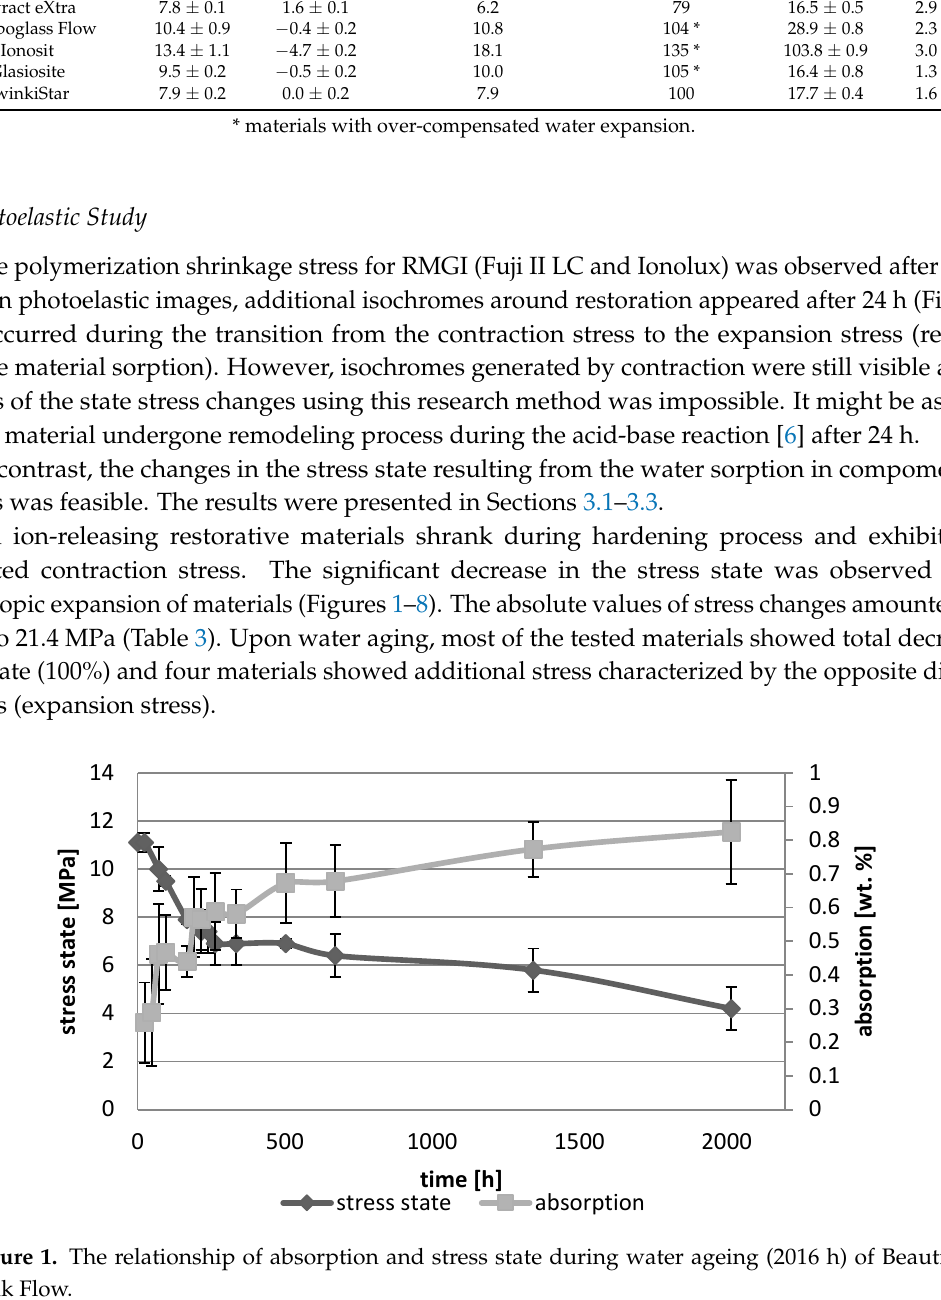
Figure 2. The relationship of absorption and stress state during water ageing (2016 h) of Beautifil Flow Plus F00.